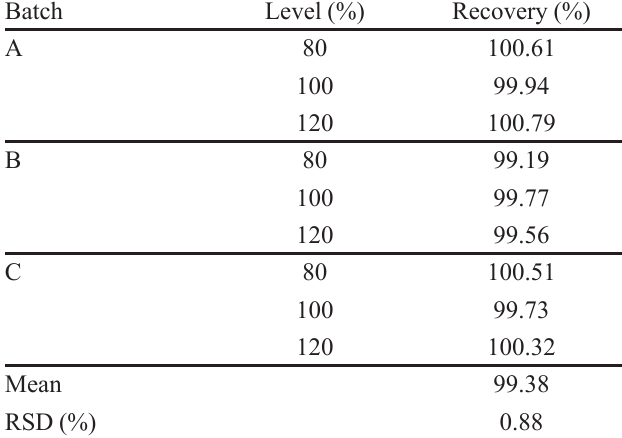
TABLE V - Data from accuracy